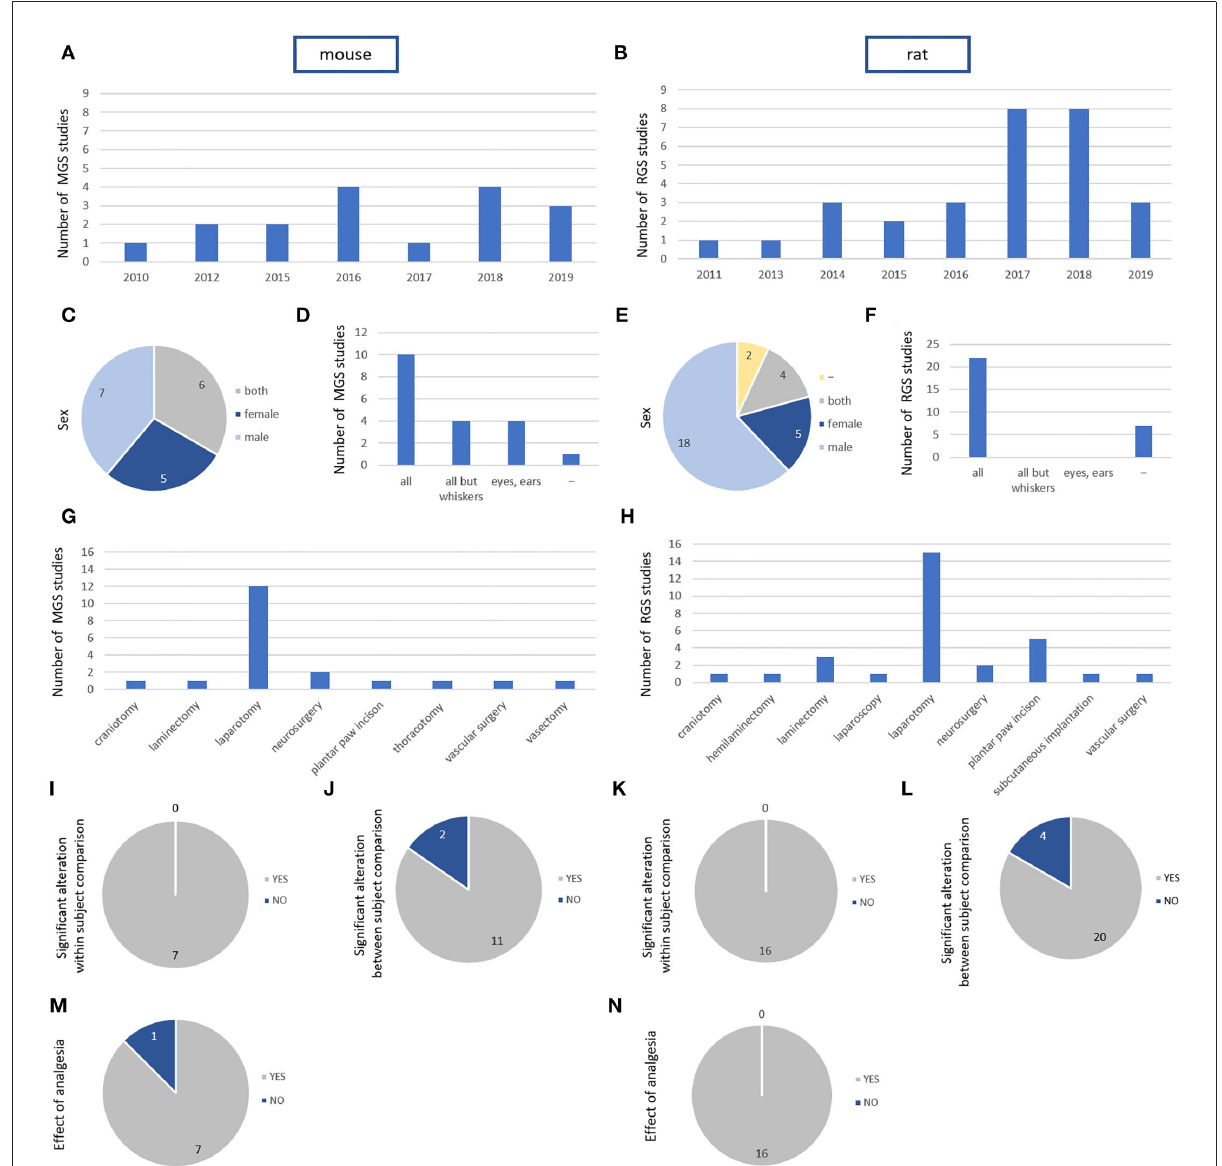
FIGURE2 Study characteristics, animal characteristics, and intervention characteristics for Mouse Grimace Scale (k = 18 studies) and Rat Grimace Scale (k = 29 studies). (A,B) Number of published studies using grimace scale for the assessment of post-surgical pain in mice (A) and rats (B) during the last decade. X-axis represents years. (C,E) Number of grimace scale studies in mice (C) and rats (E) using females, males, and both sexes. (D,F) Scored action units (AUs) in mice (D) and rats (F) . All but whisker: all AUs were scored except of whisker change. Eyes, ears: narrowing of the eyes and ears changes were evaluated. (G,H) Type of intervention in mice (G) and rats (H) . (I,K) Studies describing within-subject comparison in mice (I) and rats (K) . The within-subject comparison revealed an influence of the surgical intervention in all mouse and all rat studies. (J,L) Studies describing between-subject comparison in mice (J) and rats (L) . (M,N) Studies describing an analysis of the impact of an analgetic drug on MGS (M) or RGS (N) in comparison with a control group. The analysis revealed an influence in all rat